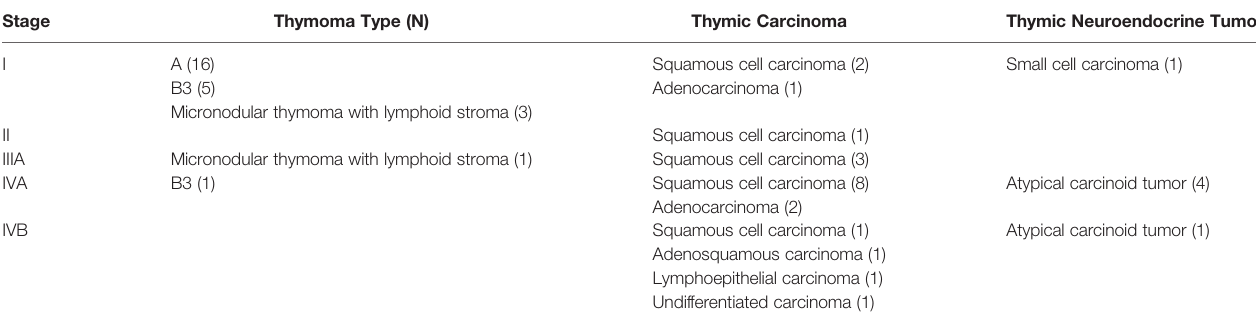
TABLE 3 | Stage distribution of thymic epithelial tumors of the study population (N=53) a .